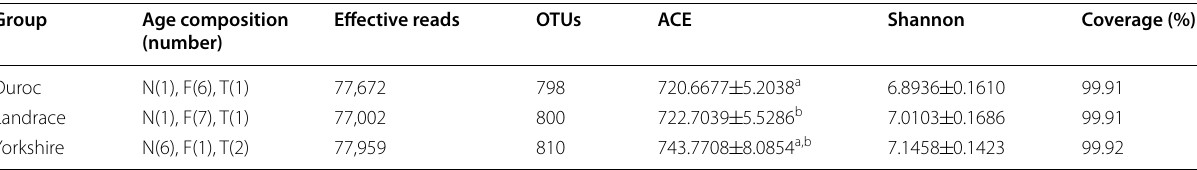
Note: N, F and T represent ages of nine, fifteen and twenty months respectively. The same letters in the superscript indicated a significant difference between the two groups (p < 0.05)